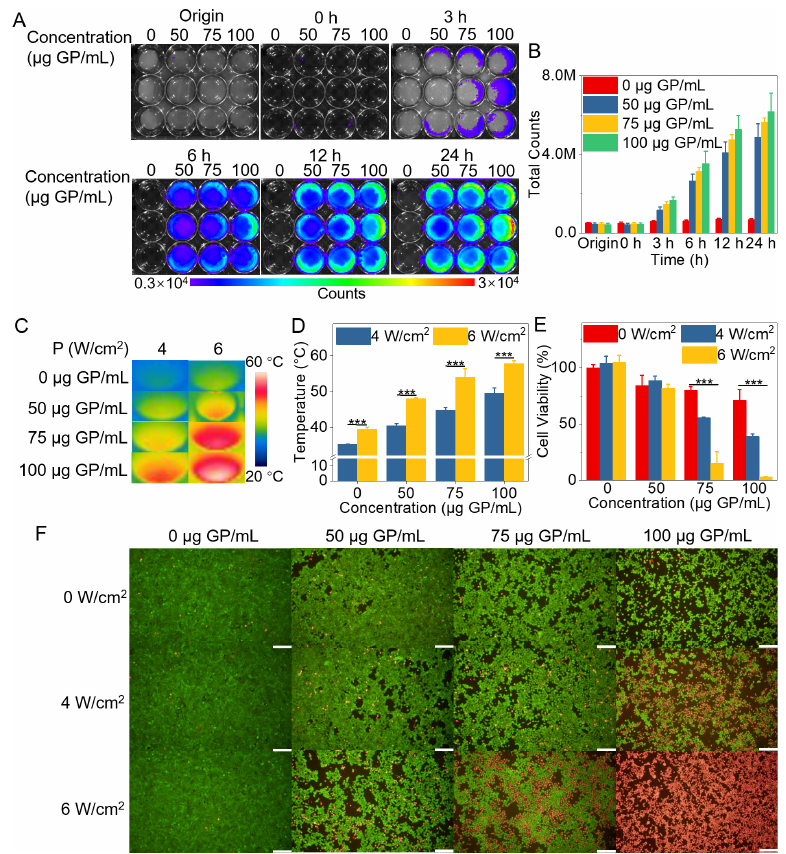
Figure 3. The cytological experiment of ACG hydrogel in vitro. ( A ) The fluorescent images of the 4T1 cells incubated with ACG hydrogel (0, 50, 75, and 100 μ g GP/mL) for 0 h, 3 h, 6 h, 12 h, and 24 h, n = 3. ( B ) The quantitative analysis of fluorescent counts in each well of ( A ), shown as means ± SD, n = 3. ( C ) The infrared thermal photos of 4T1 cells incubated with ACG hydrogel (0, 50, 75, and 100 μ g GP/mL) under 808 nm laser irradiation (4 or 6 W/cm 2 , 10 min). ( D ) The quantitative analysis of temperature change of different treatments, shown as means ± SD, n = 3, was evaluated by two-way ANOVA tests, *** p < 0.001. ( E ) Cell viabilities of 4T1 cells incubated with ACG hydrogel (0, 50, 75, and 100 μ g GP/mL) under 808 nm laser irradiation (0, 4, and 6 W/cm 2 , 10 min), shown as means ± SD, evaluated by two-way ANOVA tests, *** p < 0.001. ( F ) The dual staining of living/dead cells with Calcein AM and PI is shown as green and red, respectively. Scale bar: 200 μ m.